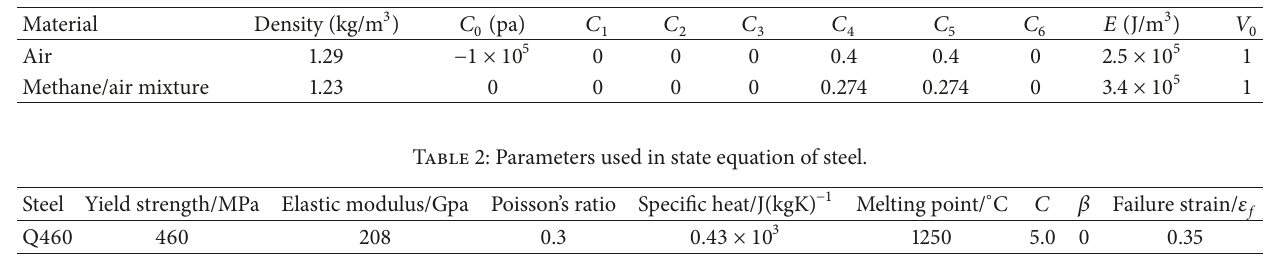
Table 1: Parameters used in linear polynomial equation of state.